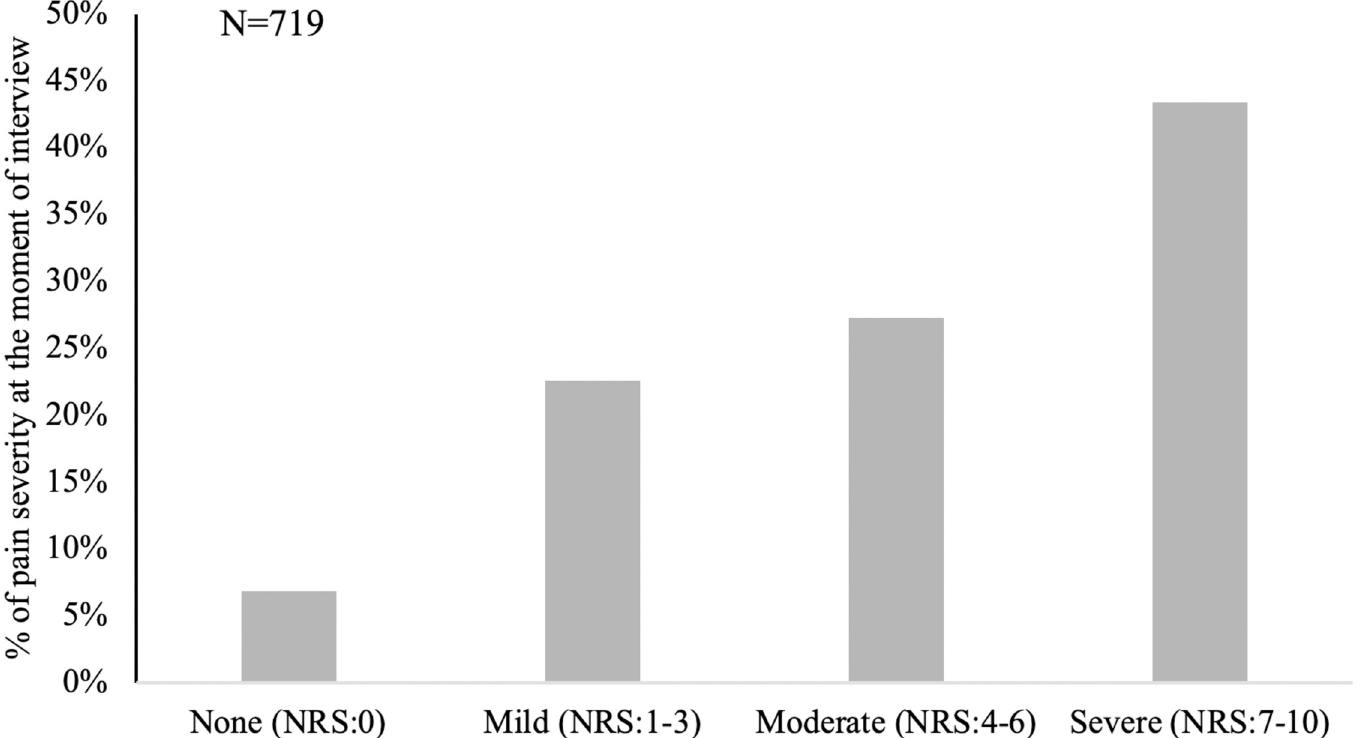
Fig 1. Pain severity at the moment of the interview. Seven hundred and nineteen patients had experienced pain within the last 24 hours when responding to the questionnaire. The pain severity at the moment of the interview was divided into 4 grades using a Numerical Rating Scale (NRS): none (0), mild (1–3), moderate (4–6), and severe pain (7–10). The percentage of each group is